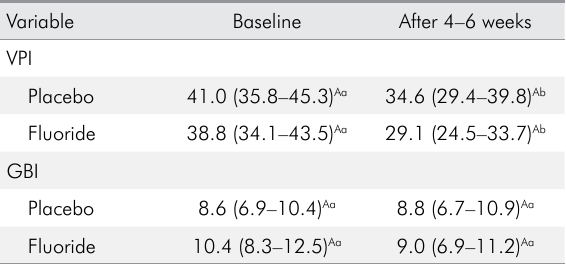
Table 2. Visible plaque index (VPI) and gingival bleeding index (GBI) at baseline and after 4-6 weeks. Mean (95% confidence interval). n = 98 patients.